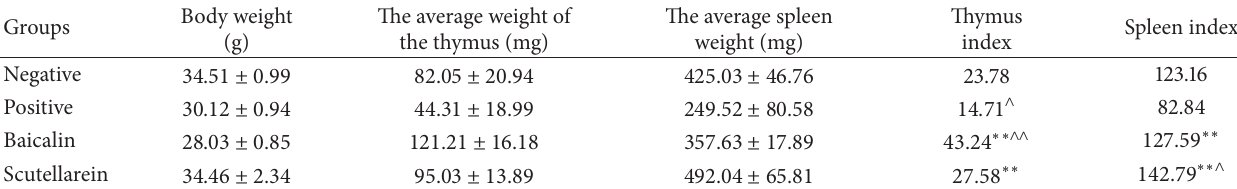
Table 2: The effect of baicalin and baicalein on U14 cervical thymus index and spleen index.